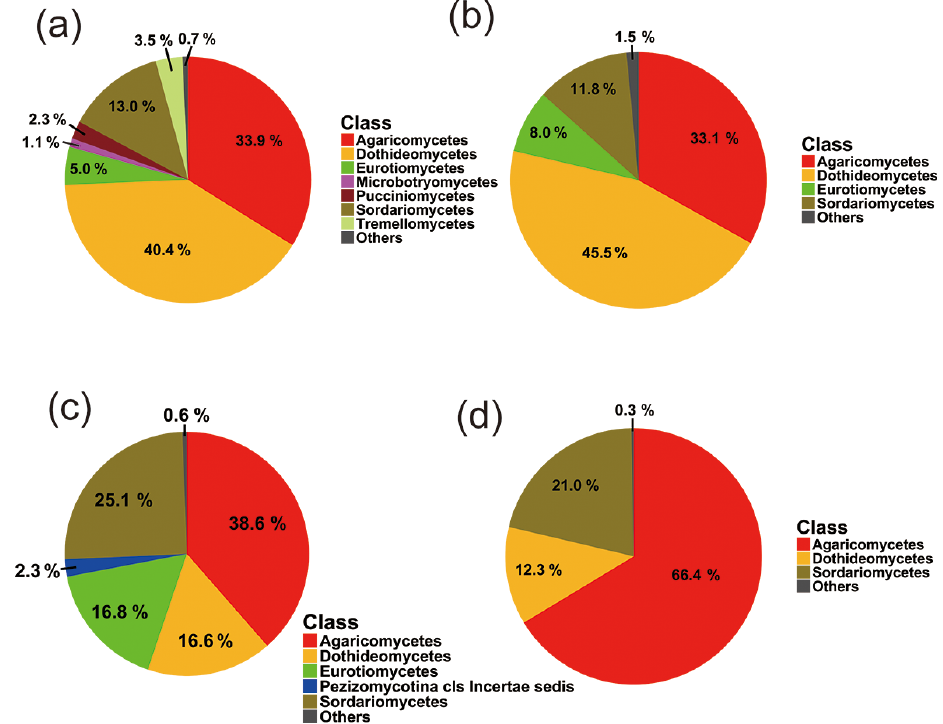
Figure 16. Variations in the fungal community composition at the class level in (a) dust samples of Erenhot, b) non-dust samples of Erenhot, (c) dust samples of R-DzToUb, and (d) non-dust samples of